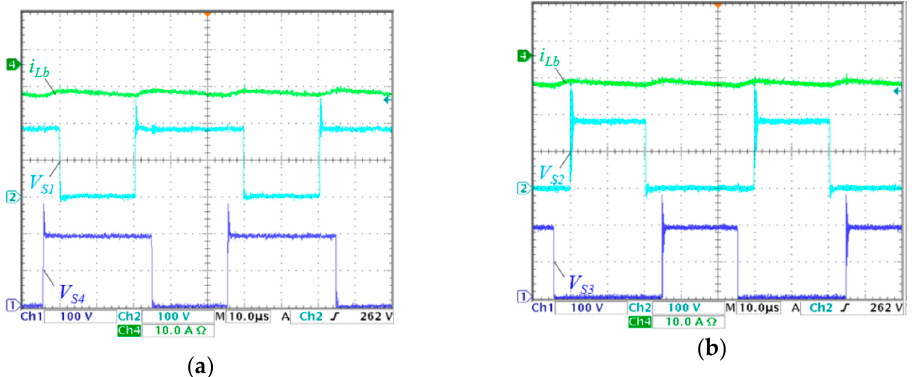
Figure 10. The experimental waveforms of the conventional converter in the step-down mode: ( a ) i Lb , V S1 , and V S4 ; ( b ) i Lb , V S2 , and V S3 .